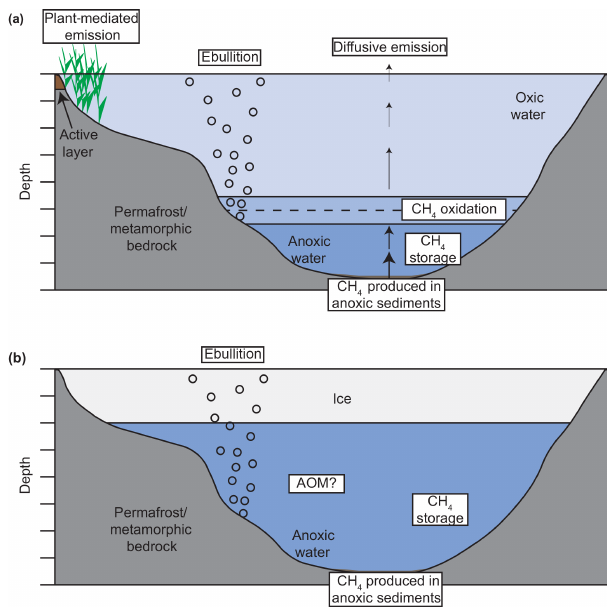
Figure 1. Methane emission pathways and dynamics in a bedrock controlled thermokarst lacustrine system under both open-water and ice-covered